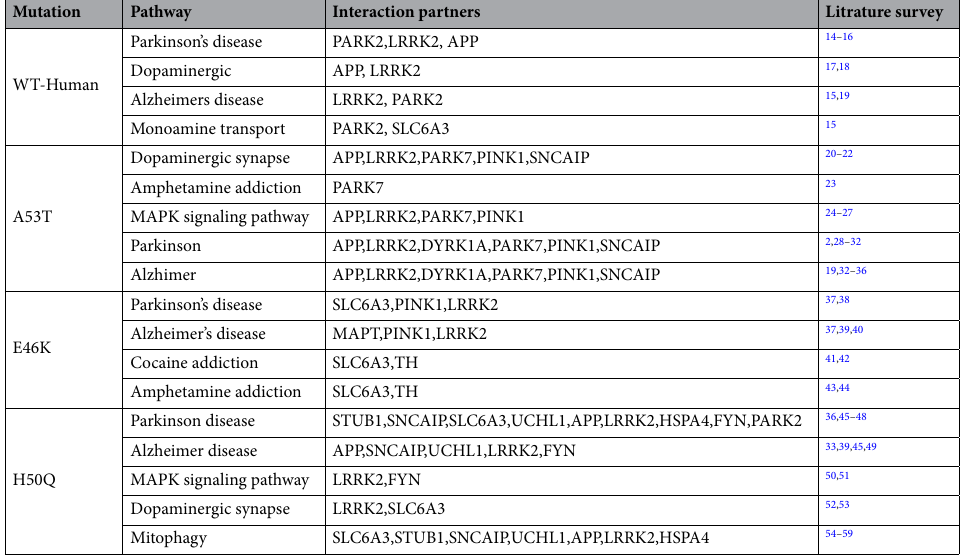
Table 2. Validating the pathway outcomes from the available